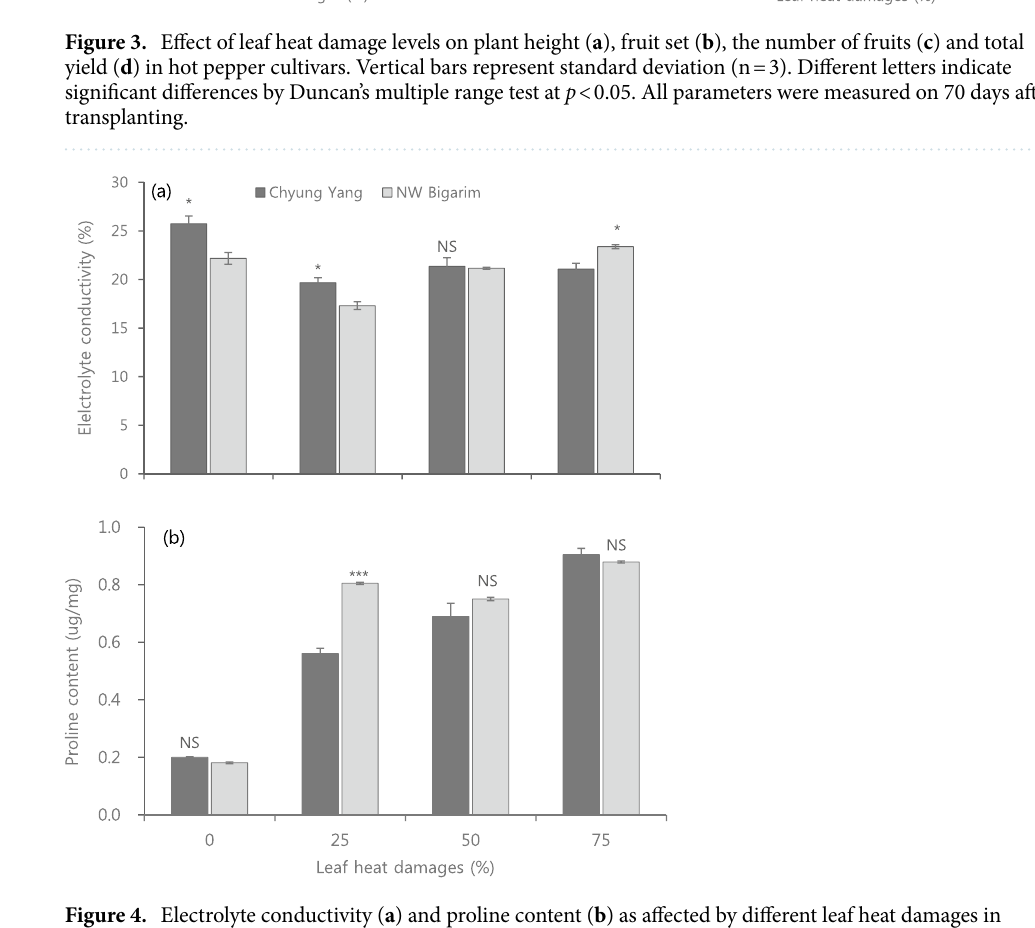
Figure 4. Electrolyte conductivity ( a ) and proline content ( b ) as affected by different leaf heat damages in seedlings of two hot pepper cultivars grown in 42 °C for 9 to 10 days. Vertical bars represent standard deviations (n = 3). NS, * and *** indicate not significant and significant at the P < 0.05 and P < 0.001 levels in t-test,